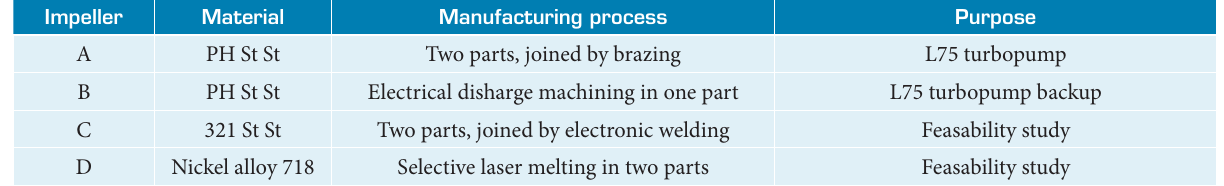
Table 1. Overview of materials, manufacturing processes and purpose of studied